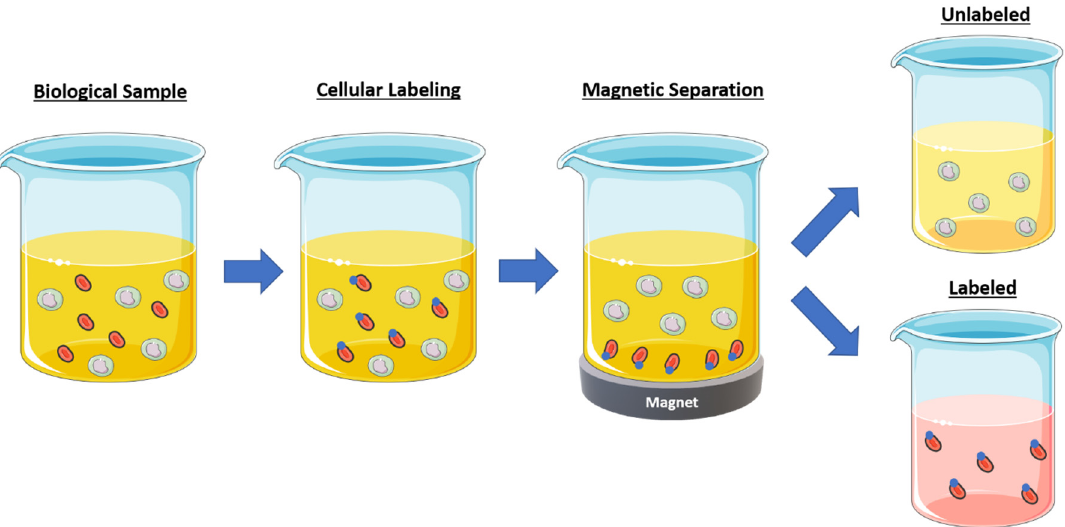
Figure 7. Magnetic batch separation for cell separation. Initially cells are suspended and then the desired cell population is labeled with magnetic nanoparticles. The final step depends on the selection methodology: labeled or unlabeled selection. In unlabeled selection, the desired cells remain in the supernatant and the labeled cells are magnetically captured via a permanent magnet (also known as negative selection). Alternatively, the cells of interest can be labeled and magnetically captured, and the supernatant can be discarded (also known as positive selection). Art modified from Servier Medical Art, licensed under a Creative Common Attribution 3.0 Generic License, http://smart.servier.com/ (accessed on 20 April 2021).